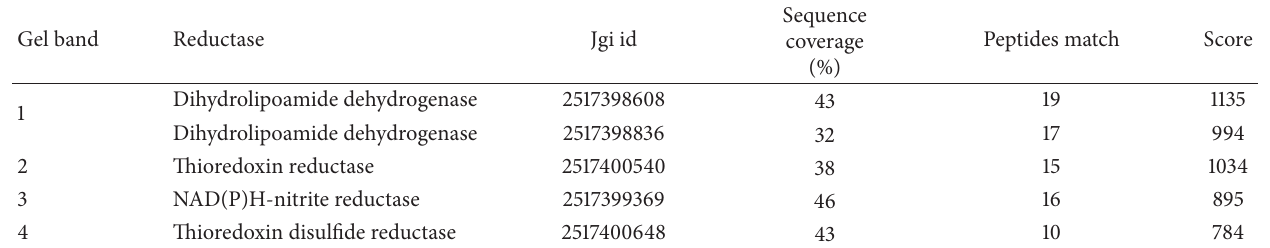
Table 2: Fe(III) reductases identified by MS analysis of active bands in zymogram gels.